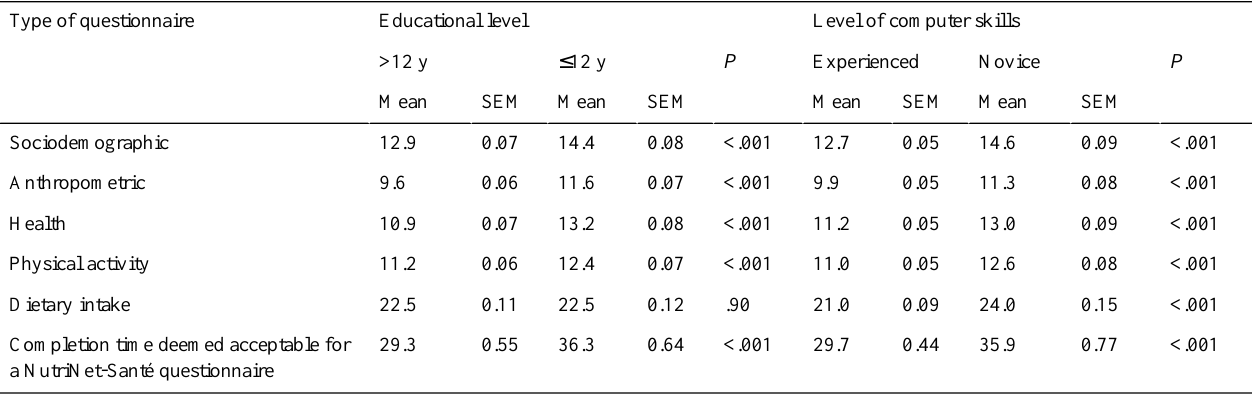
Table 6. Comparison of mean response time for questionnaires (in minutes) according to educational level and self-evaluated computer skills, NutriNet-Santé Study, France, 2013. a